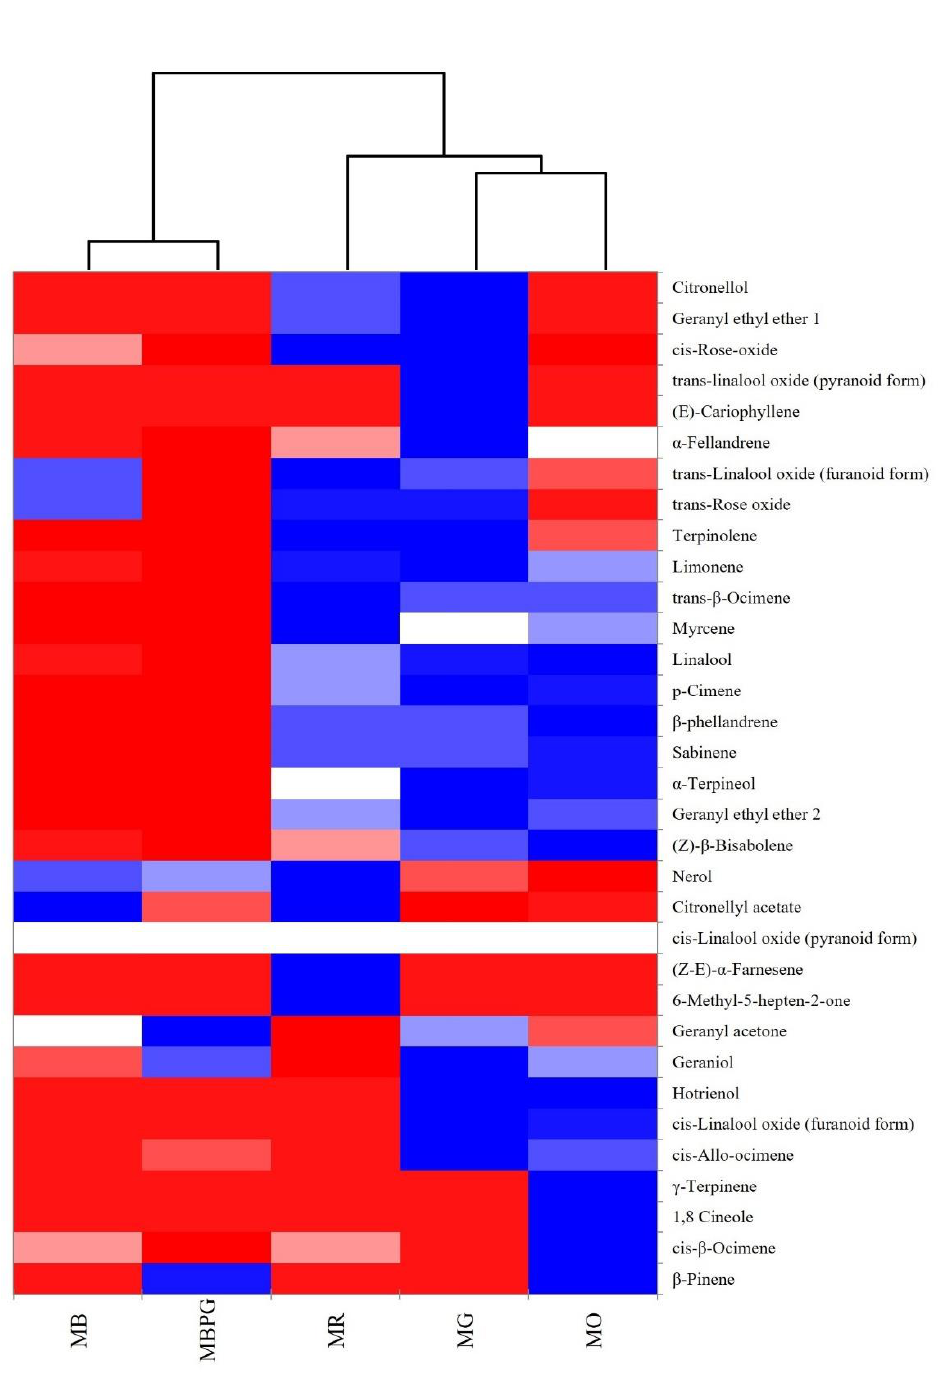
Figure 4. Heat map of the fortified Moscato wines from different varieties in terms of varietal aroma